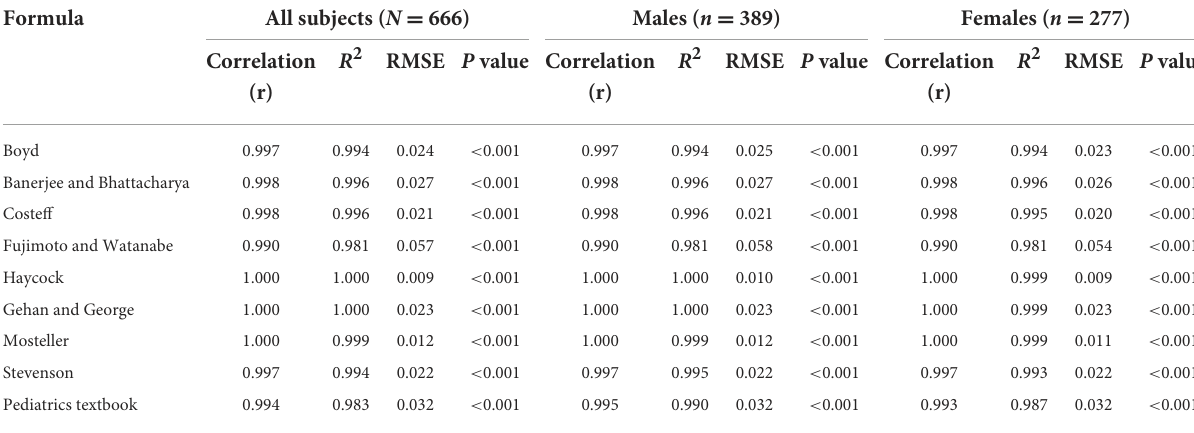
TABLE 4 Correlation between the BSA values of the different formulas and the mean value.